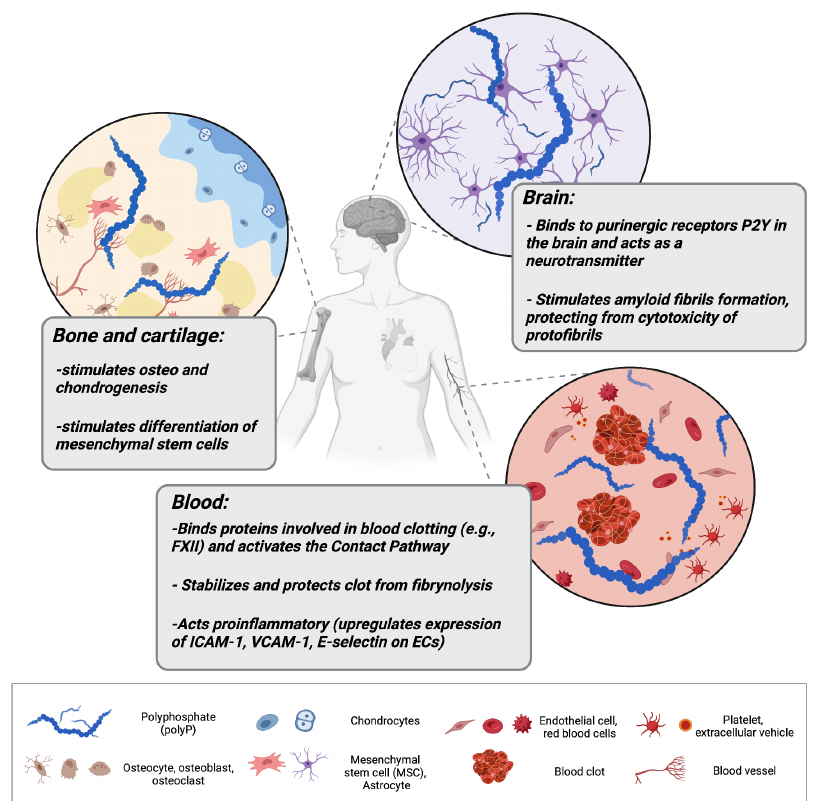
Figure 1. Polyphosphate (polyP) regulates a variety of processes in different tissues in the human organism. In bone tissue, polyP stimulates osteogenesis and chondrogenesis, and promotes the growth and differentiation of bone marrow-derived mesenchymal stem cells (MSCs). In the brainstem, it can be taken up by activated astrocytes and act as a mediator of signal transmission. In the cardiovascular system, polyP can be released within extracellular vehicles by activated platelets, where it activates the contact pathway of blood clotting, stabilizes fibrin clot structure, and mediates proinflammatory responses by activating endothelial cells